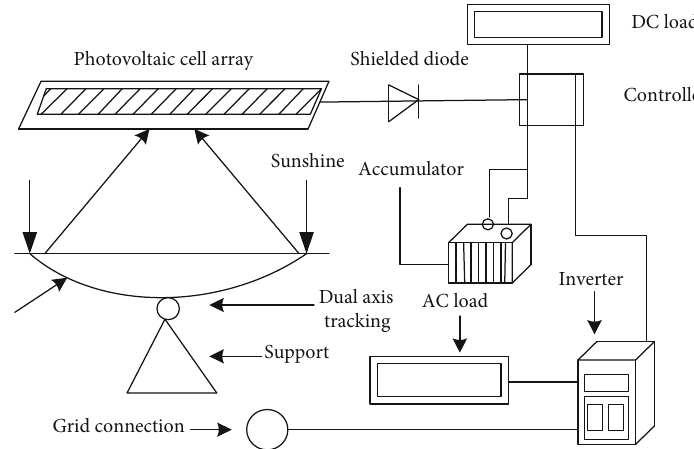
Figure 2: Trough type concentrating photovoltaic power generation system.